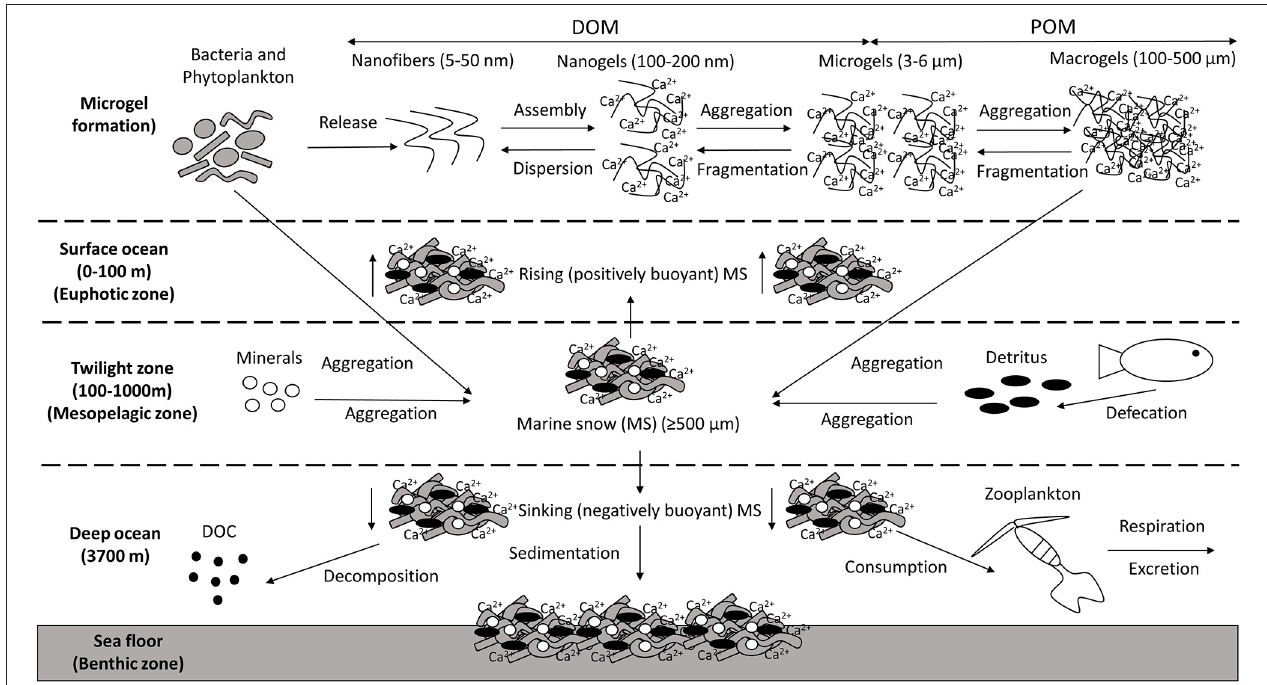
FIGURE 1 | Marine snow (MS) formation and sedimentation. Macromolecules/nanofibres are released by microbes (e.g., bacteria and phytoplankton), which assemble, forming nanogels stabilized by entanglements and Ca 2 + bonds. There is a transition in the size continuum of marine gels from dissolved organic matter (DOM) to particulate organic matter (POM) as these nanogels interpenetrate each other forming microgels. Neighboring microgels then aggregate forming macrogels [e.g., Transparent Exopolymer Particles (TEP)]. This process occurs in the euphotic zone, mesopelagic zone and the deep ocean. MS forms from aggregation of microbes and other particles, which are held together by a combination of Extracellular Polymeric Substances (EPS) and the macrogels generated. Other material can be incorporated into these aggregates, such as minerals and detritus. Positively buoyant MS particles rise and can float on the ocean surface. Negatively buoyant MS particles sink, where they can be altered by the activities of heterotrophic microbes and zooplankton prior to sedimentation on the